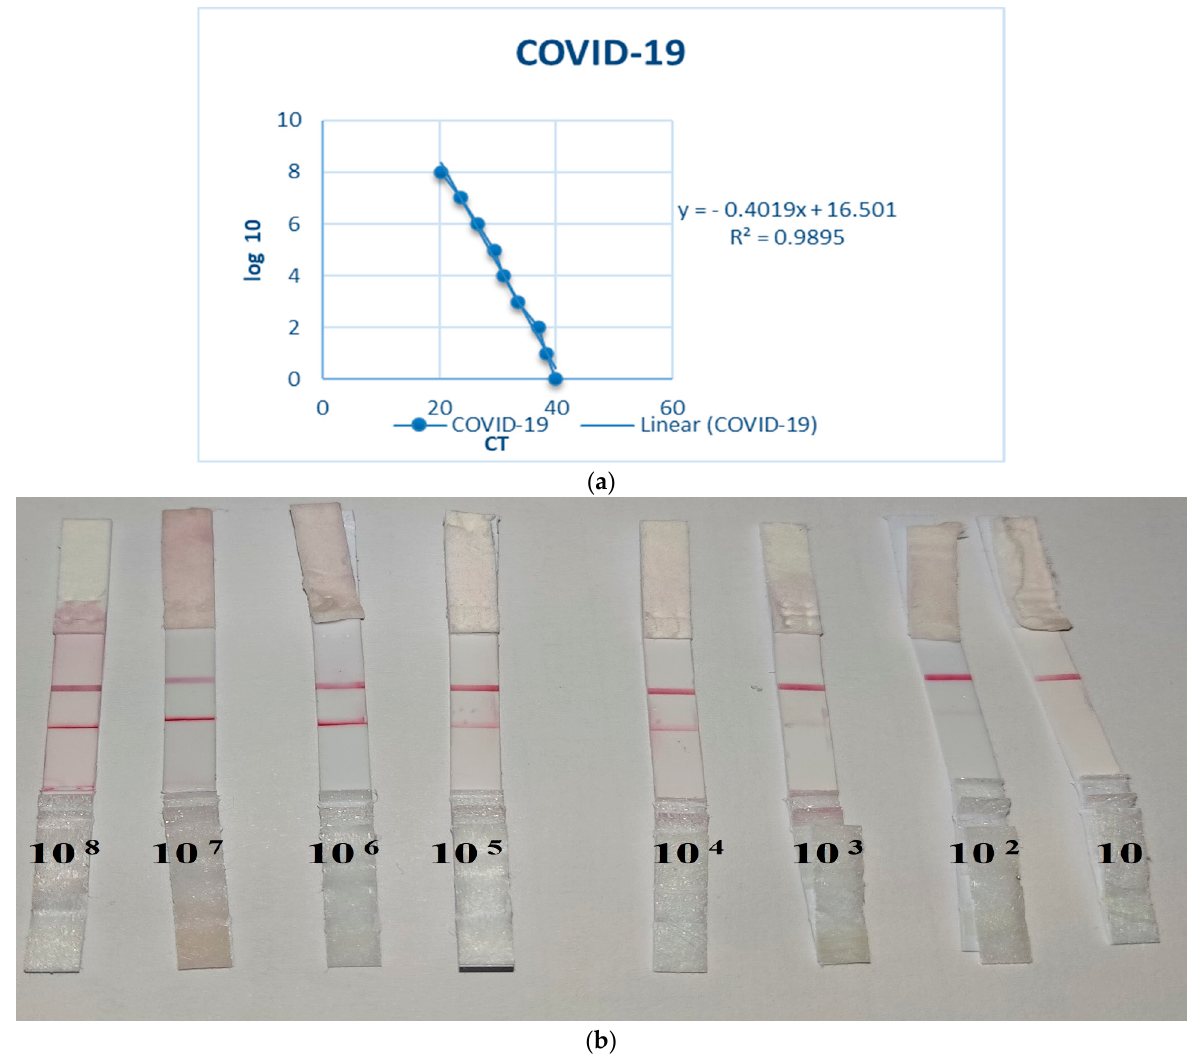
Figure 3. ( a ) Linear range and the calculation equation for SARS-CoV-2; ( b ) Limit of detection (LOD) for SARS-CoV-2 detection by the developed LFI for antigen detection using serial dilutions of phosphate buffer saline (PBS) spiked with SARS-CoV-2. Table 1. Limit of detection (LOD) of SARS-CoV-2 antigens by the developed LFI antigen test, as compared to RT-qPCR using phosphate buffer saline samples spiked with SARS-CoV-2. Method